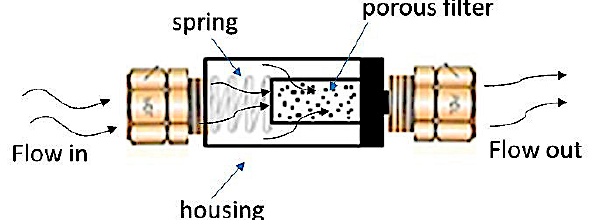
Figure 7. Illustration of the turbulent flow in the dynamic system using the porous filter.